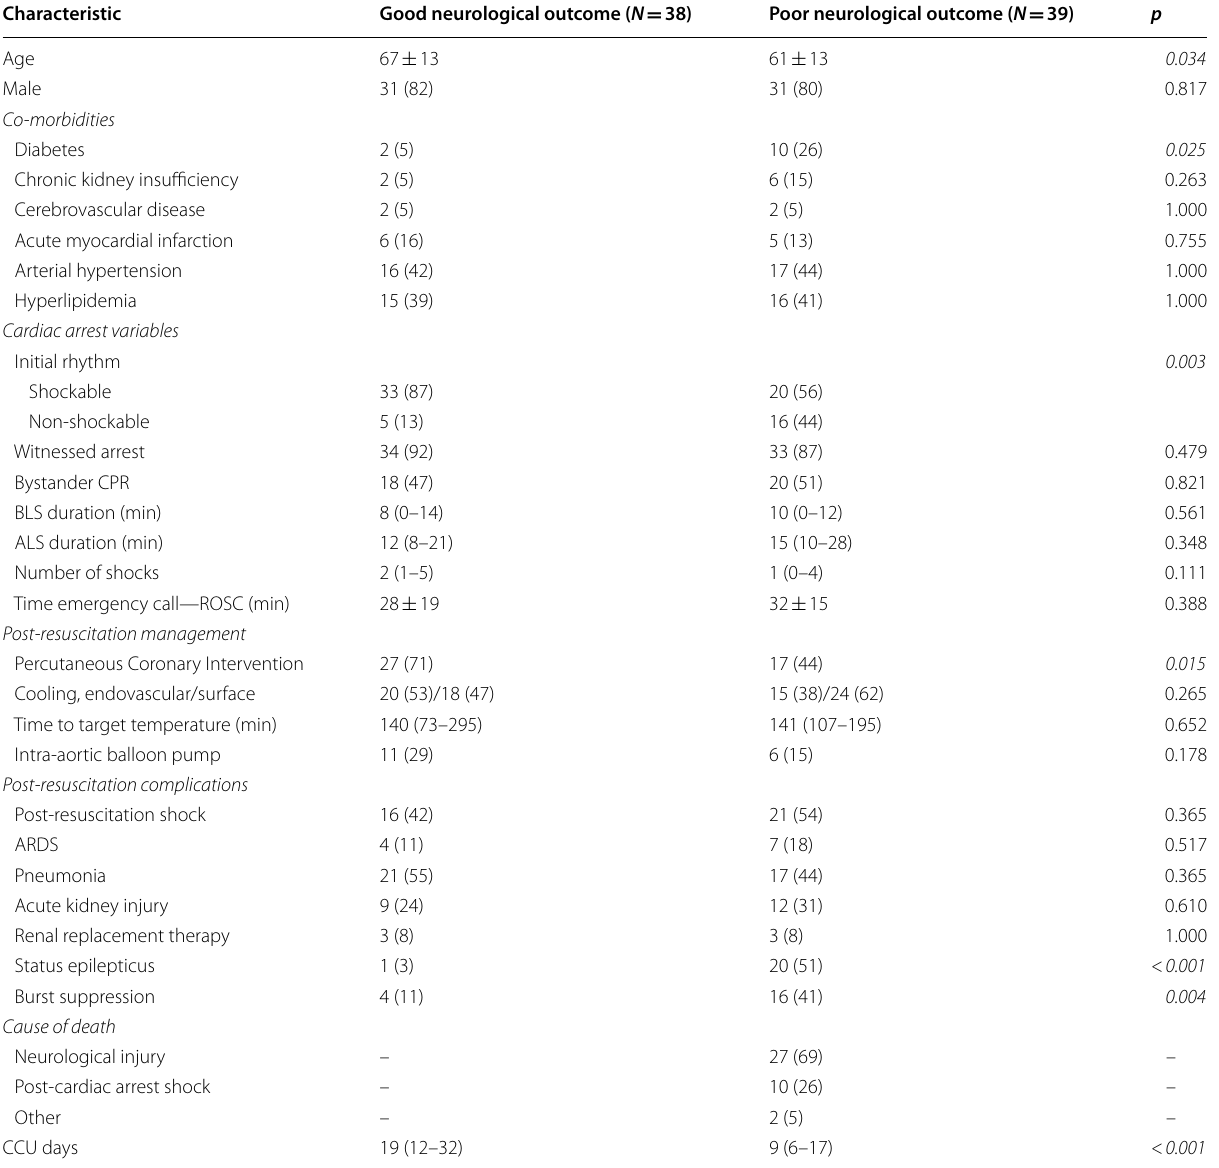
Table 1 Baseline characteristics and post-resuscitation management and